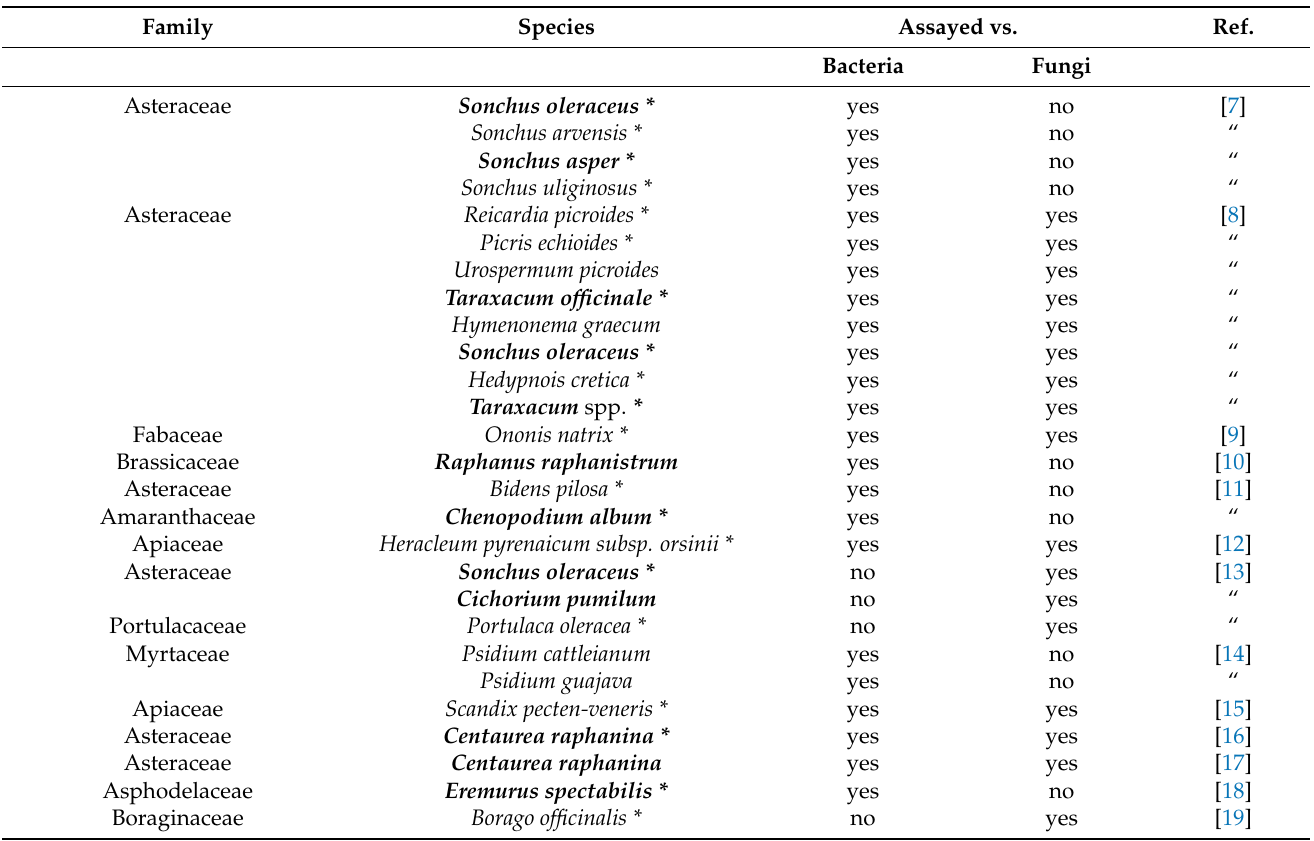
Table 1. List of the thirty-eight studies analyzed in this review, with a total number of 74 MWEPs species. In bold we indicate the species studied in more than one article. The species classified as antimicrobial by passing our stringent threshold were 57 (77%) in number and are marked with an asterisk (*) when associated with the reference study in which the antimicrobial properties were